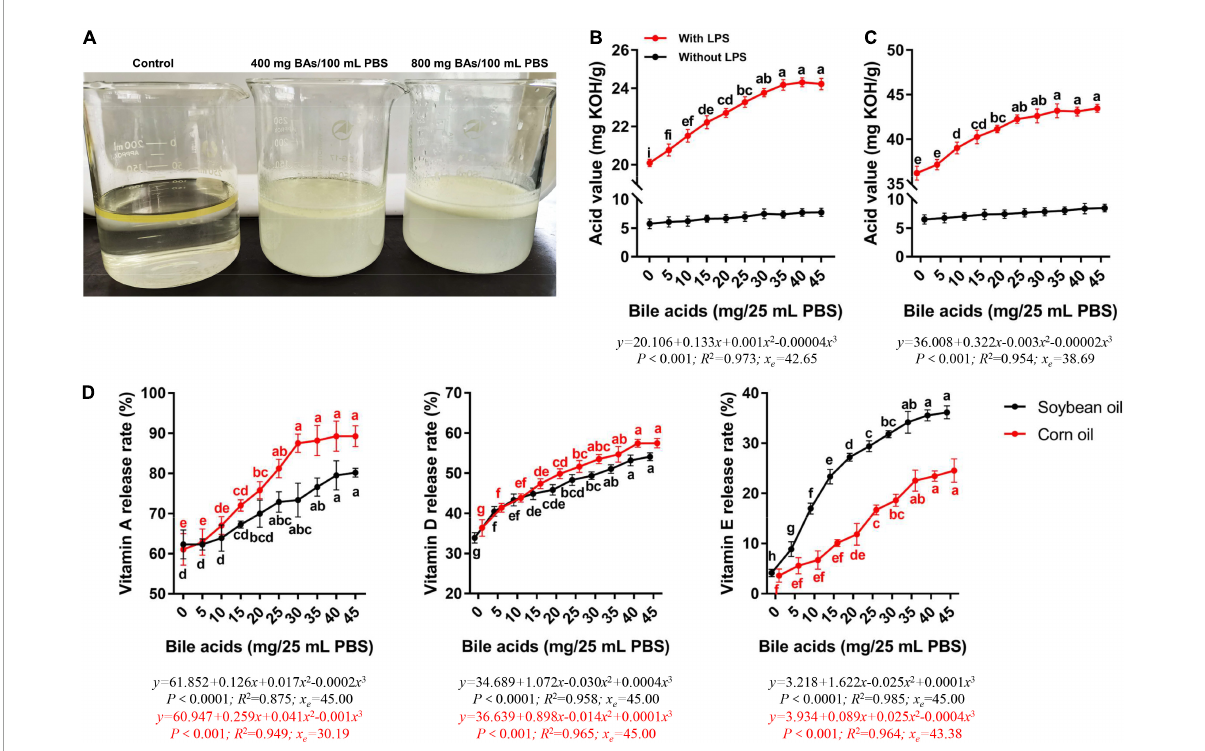
FIGURE1 Porcine bile acids promoted emulsification, fat hydrolysis, and release of fat-soluble vitamins in vitro . BAs, bile acids. PBS, phosphate buffered solution. KOH, potassium hydroxide. LPS, lipase. (A) Emulsification of porcine bile acids. (B) Porcine bile acids promoted the hydrolysis of lipase to release more fatty acids in soybean oil. (C) Porcine bile acids promoted the hydrolysis of lipase to release more fatty acids in corn oil. (D) Porcine bile acids enhanced the release of vitamins A, D and E from fat. (B–D) Values are indicated as means ± SD. Different lowercase letters indicate significant differences. The x e represents the abscissa value at the extremum of the regression equation in this definition